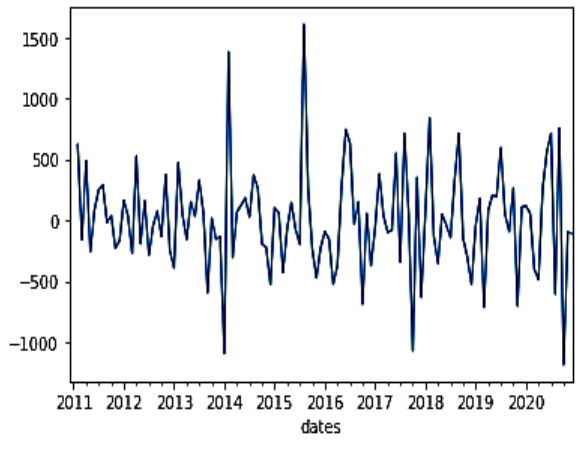
Figure 5. Cumulative EVI anomalies plot after second